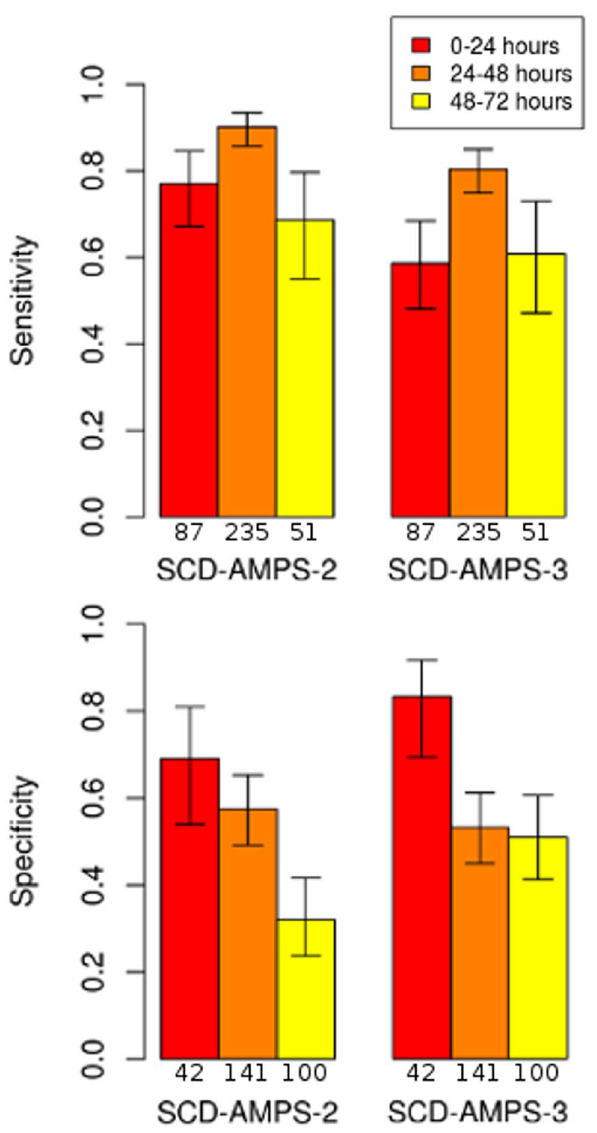
Fig. 4. The sensitivity and specificity of SCD-AMPS as a function of the amount of time between collecting samples and running tests. The specificity shows a decline over each 24 hour increment, with a significant decline over 48 hours (p-value , 0.0005). The sensitivity increased between the first and second time interval, but then decreased between the second and third interval (p-values , 0.01). The sample size used for each time interval is provided below each